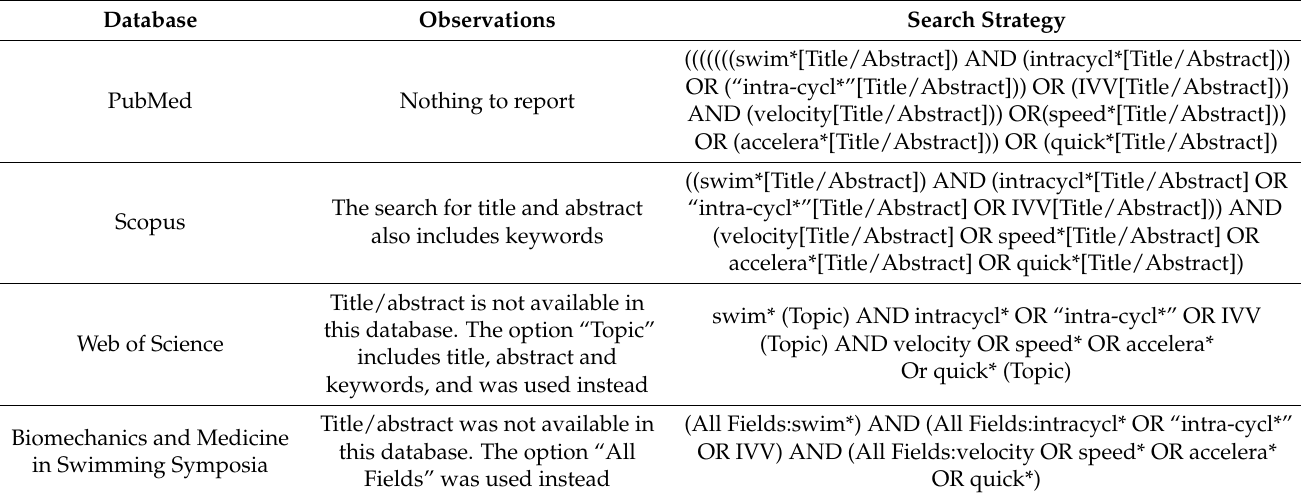
Table 1. Full search strategies for PubMed, Scopus, Web of Science databases, and Biomechanics and Medicine in Swimming